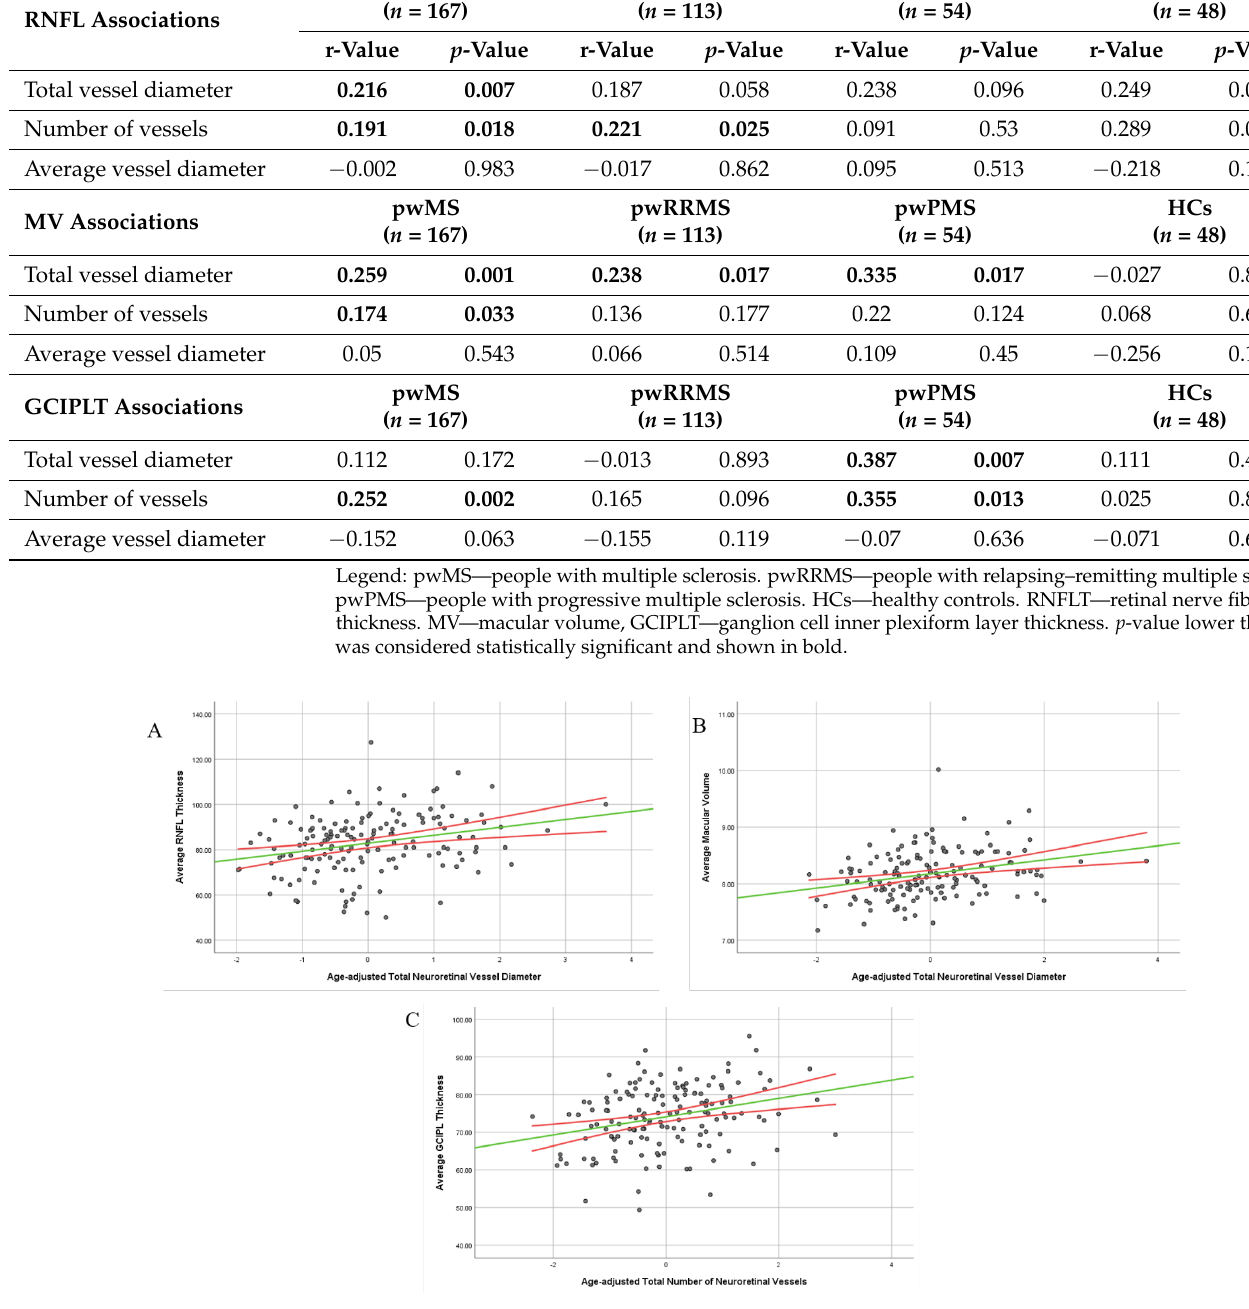
Figure 4. Age-adjusted correlations in pwMS between neuroretinal vascular measures and anatomical retinal layers. pwMS — people with multiple sclerosis, RNFL — retinal nerve fiber layer, MV — macular volume, GCIPL — ganglion inner plexiform layer. ( A ) Age-adjusted relationship between average RNFL thickness and total neuroretinal vessel diameter, ( B ) age-adjusted relationship between average MV and total neuroretinal vessel diameter, ( C ) age-adjusted relationship between average GCIPL and total number of neuroretinal